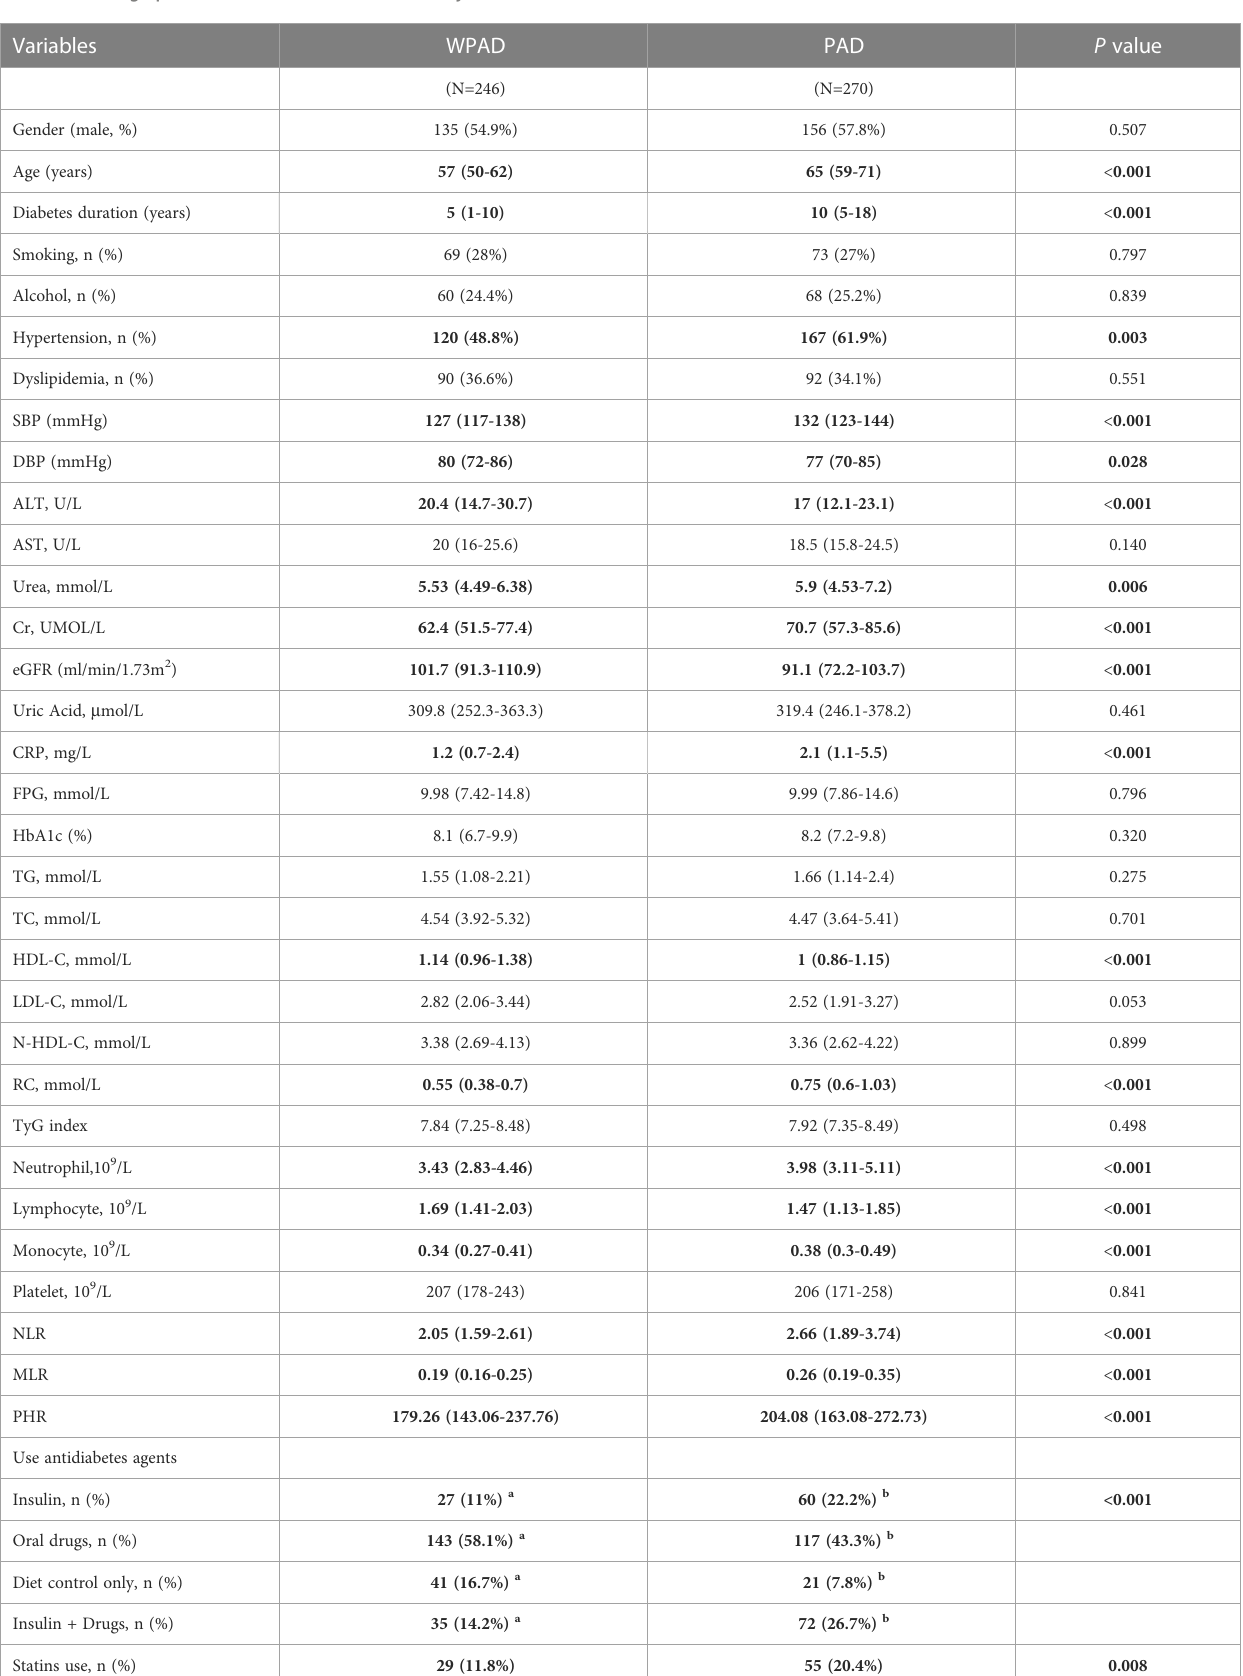
TABLE 1 Demographic and clinical data of diabetic subjects with and without